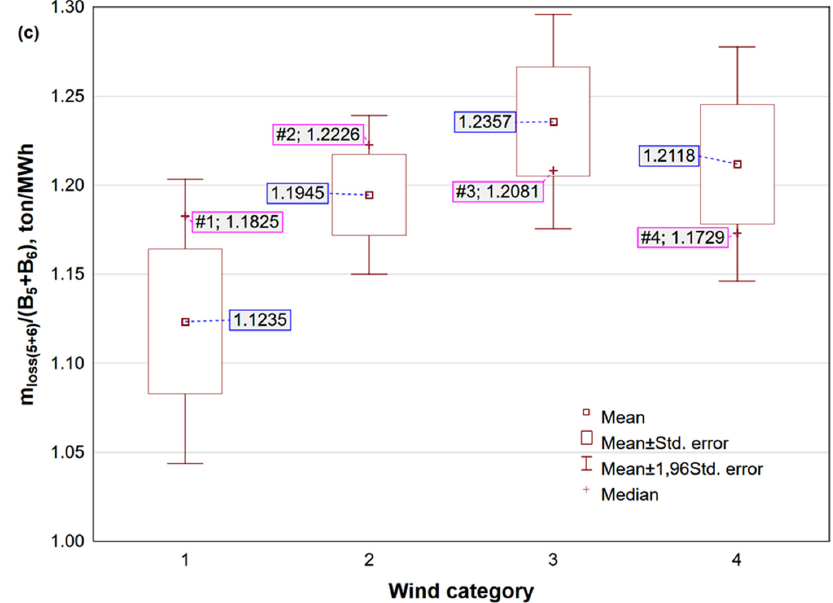
Figure 8. Water losses due to evaporation and drift related to the power of units for humidity φ = 70 ± 5% and ambient temperature: ( a ) T amb = 7 ± 1 °C; ( b ) T amb = 15 ± 1 °C; ( c ) T amb = 22 ± 1 °C (symbol #+number means wind category).